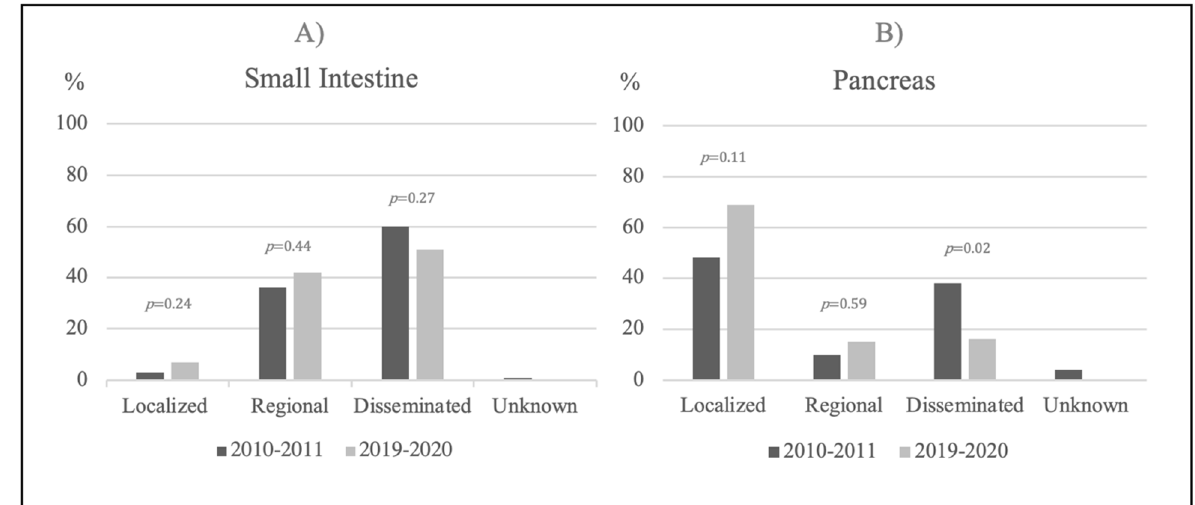
Figure 2. Time trends in disease stage at referral. ( A ) Time trends in disease stage at referral of small intestinal NETs in the two calendar years 2010–2011 and 2019–2020. ( B ) Time trends in disease stage at referral of pancreatic NETs in the two calendar years 2010–2011 and 2019–2020. The p -value illustrates the difference between the calendar periods. Abbreviation: Neuroendocrine Tumor (NET).